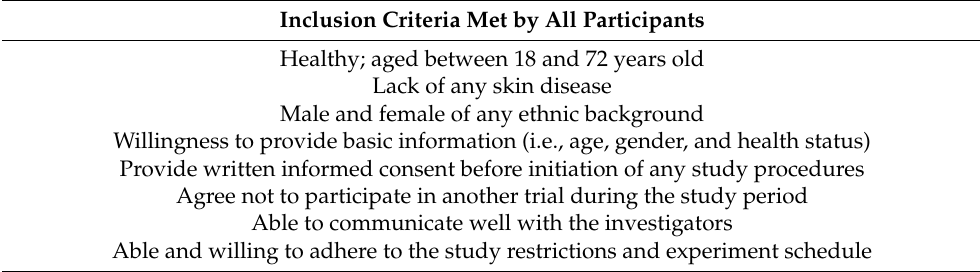
Table 3. Inclusion criteria for participants.